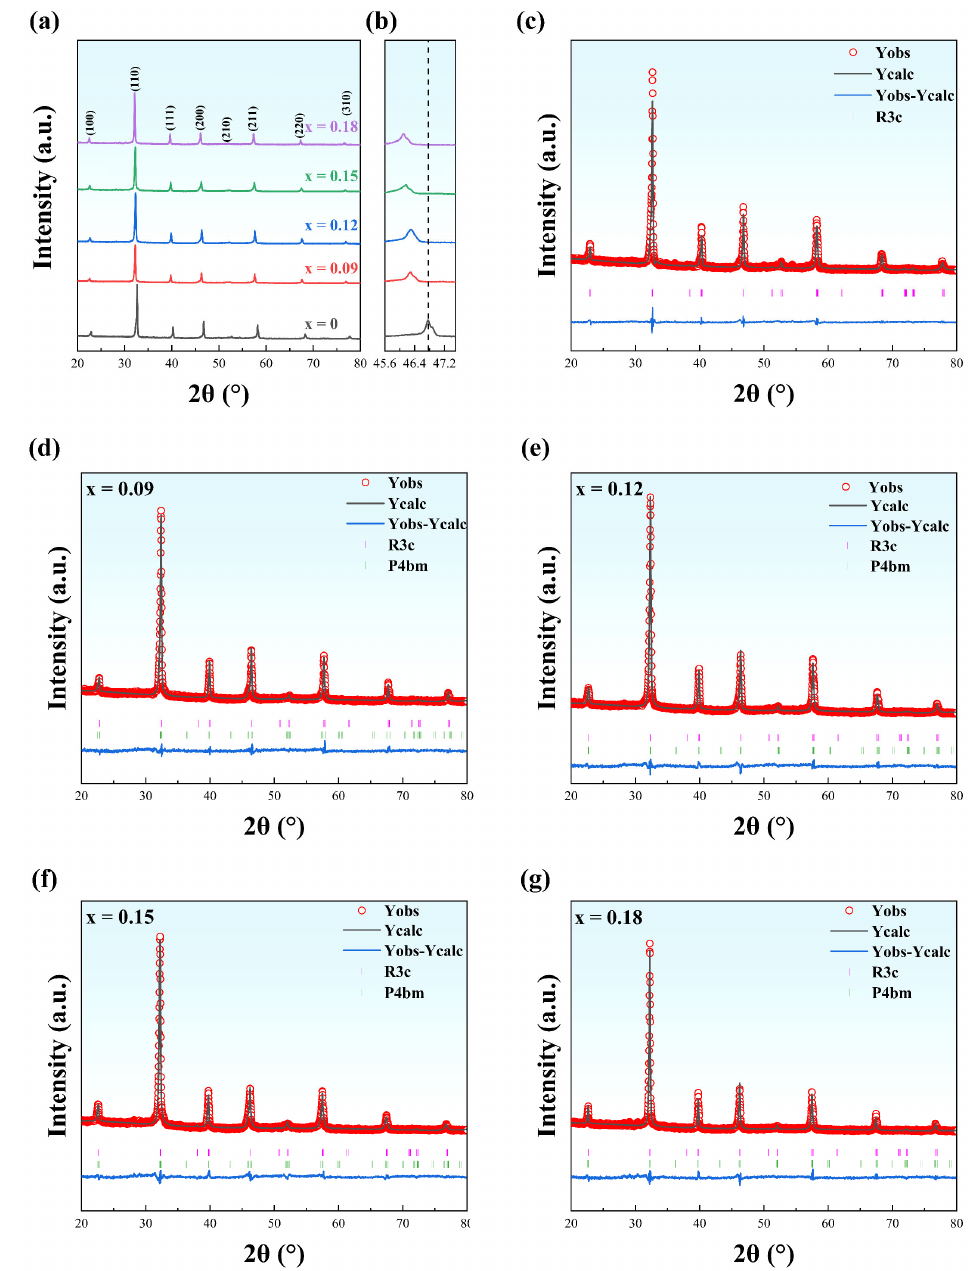
Figure 1. XRD patterns and Rietveld refinements for (1 − x)(0.7Na 0.5 Bi 0.5 TiO 3 -0.3Sr 0.7 Bi 0.2 TiO 3 )-xBi(Mg 0.5 Zr 0.5 )O 3 (NBT-SBT-xBMZ) ceramics. ( a ) XRD patterns; ( b ) magnified XRD patterns near 46 ◦ ; ( c – g ) Rietveld refinements for samples of x = 0, 0.09, 0.12, 0.15, and 0.18, respectively.